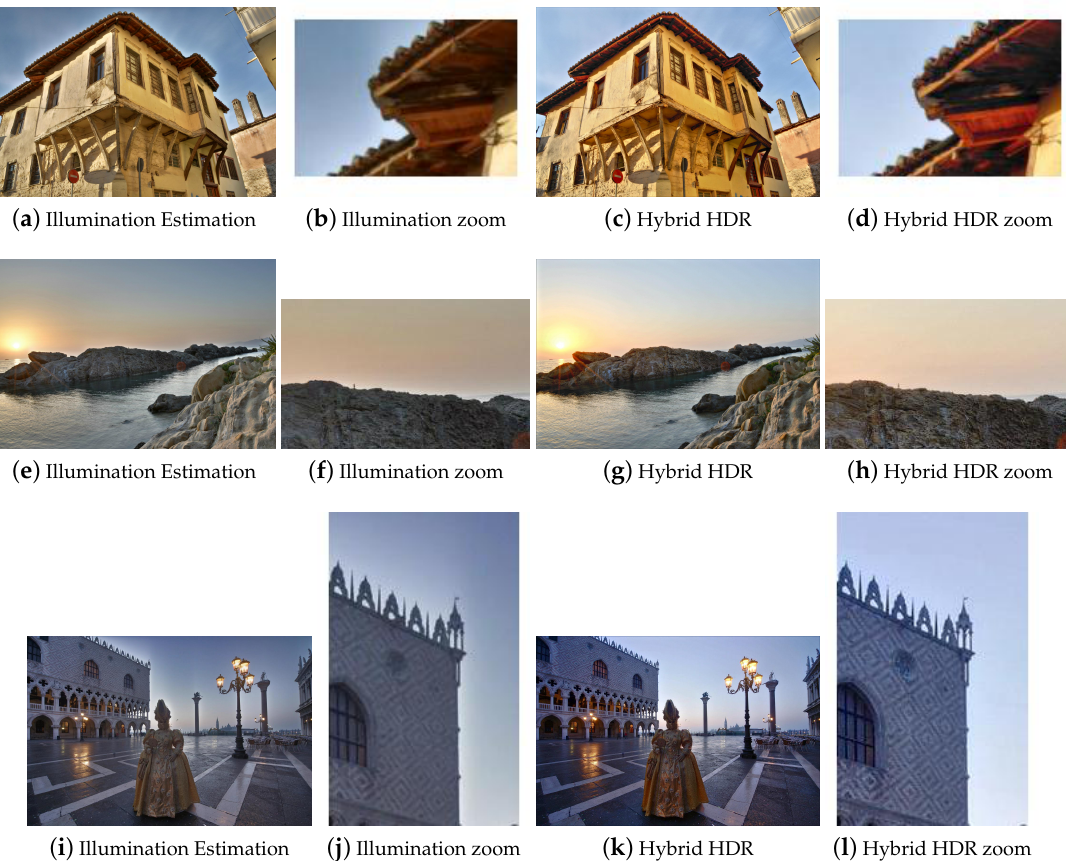
Figure 4. Comparison between the HybridHDR and the Illumination Estimation method for three image sets. More halo artifacts can be spotted in the Illumination Estimation method.